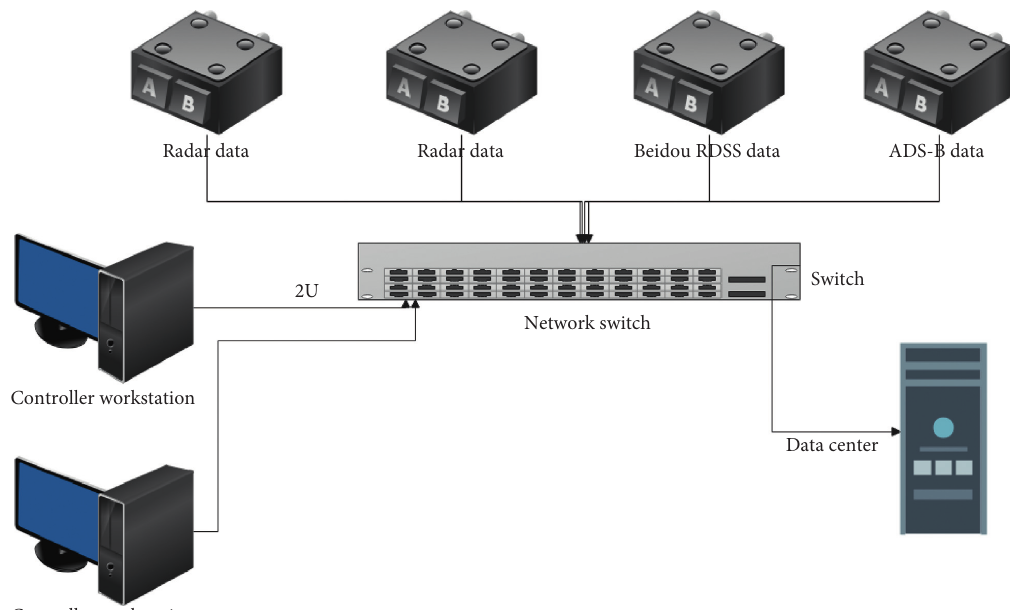
Figure 12: Network topology diagram of the general aviation surveillance system.